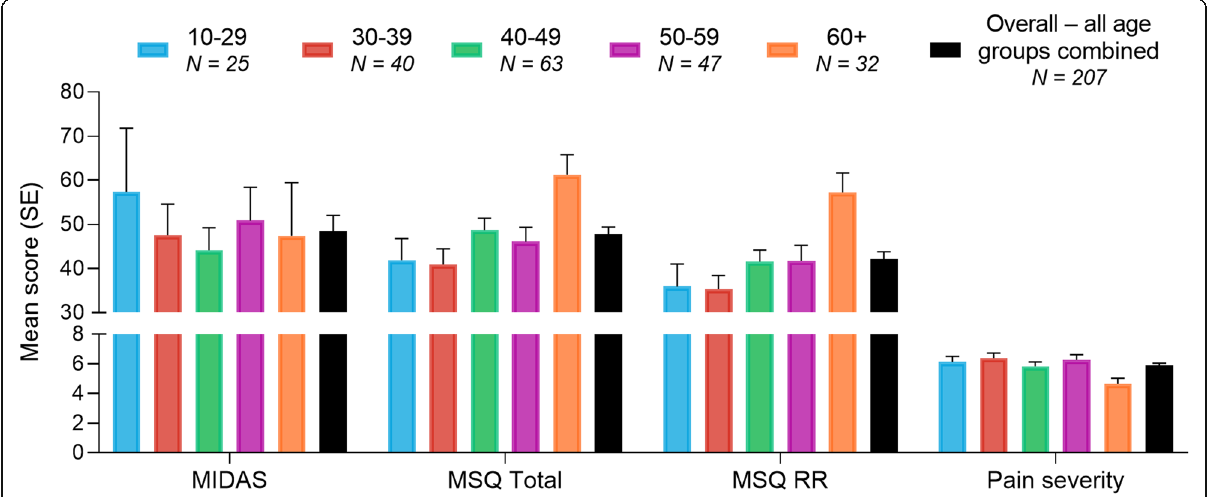
Fig. 2 Migraine-related disability, quality of life, and pain severity. Results for MIDAS, MSQ total, MSQ RR, and pain severity are presented for each age group and for overall respondents, the latter inclusive of all age groups. Results are presented as mean score (SE). MIDAS = Migraine Disability Assessment; MSQ = Migraine-Specific Quality of Life Questionnaire; RR = Role Function-Restrictive; N = Number of patients; SE = Standard